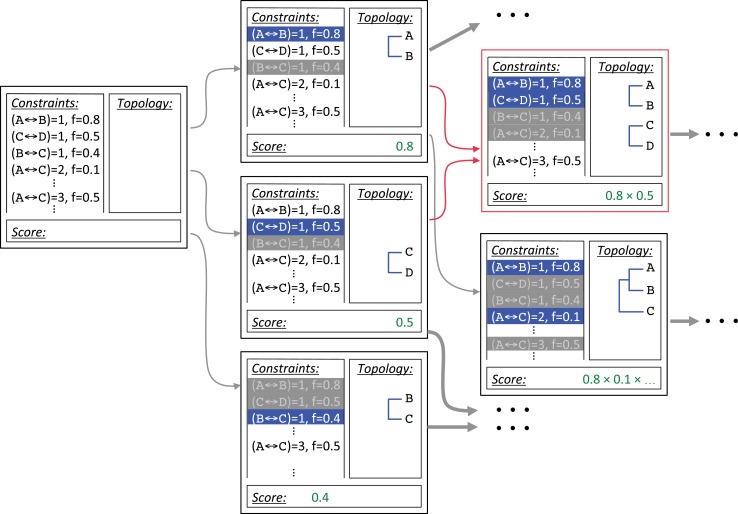
Diagram of branching during ASPEN topology reconstruction.Construction begins with the empty topology assembly on the left. Every possible extension is constructed in a copy of the initial assembly: Node {A,B} completes path (A↔B,1), node {C,D} completes path (C↔D,1), and node {B,C} completes path (B↔C,1), branching the initial assembly into three new assemblies. Path lengths completed by the introduced node and path lengths incompatible with it are marked and not revisited. Nodes {A,B} and {C,D} preclude path (B↔C,1), while node {B,C} precludes paths (A↔B,1) and (C↔D,1). Completed paths are shown in blue, precluded paths are greyed out in the corresponding assemblies. Intermediate topology scores are calculated according to the scoring function. On the next iteration construction paths for assemblies {A,B} and {C,D} collide, indicated in red. A single copy of the resulting assembly, {A,B},{C,D}, is retained. Assembly {A,B} is separately extended with node {{A,B},C}. Additional construction sequences, indicated by ellipses, are not shown.